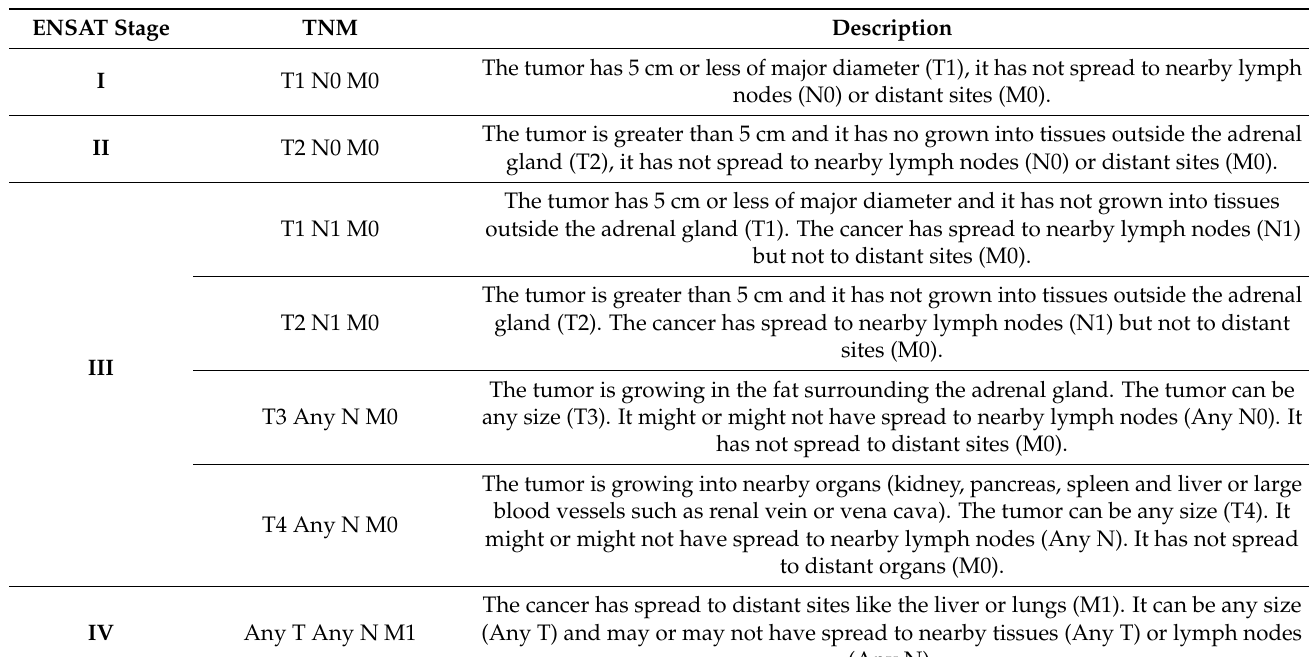
Figure 1. Imaging features suspicious for adrenocortical carcinoma. ( a ) CT scan, axial view, showing a left adrenal 7 cm inhomogeneous mass. ( b ) CT scan, coronal view of a huge mass infiltrating the spleen. ( c ) MRI showing a left 18 cm lipid-rich ACC. ( d ) Suspicious features for adrenocortical carcinoma (Adapted from dreamstime.com). Table 1. ENSAT Stages for Adrenocortical Carcinoma